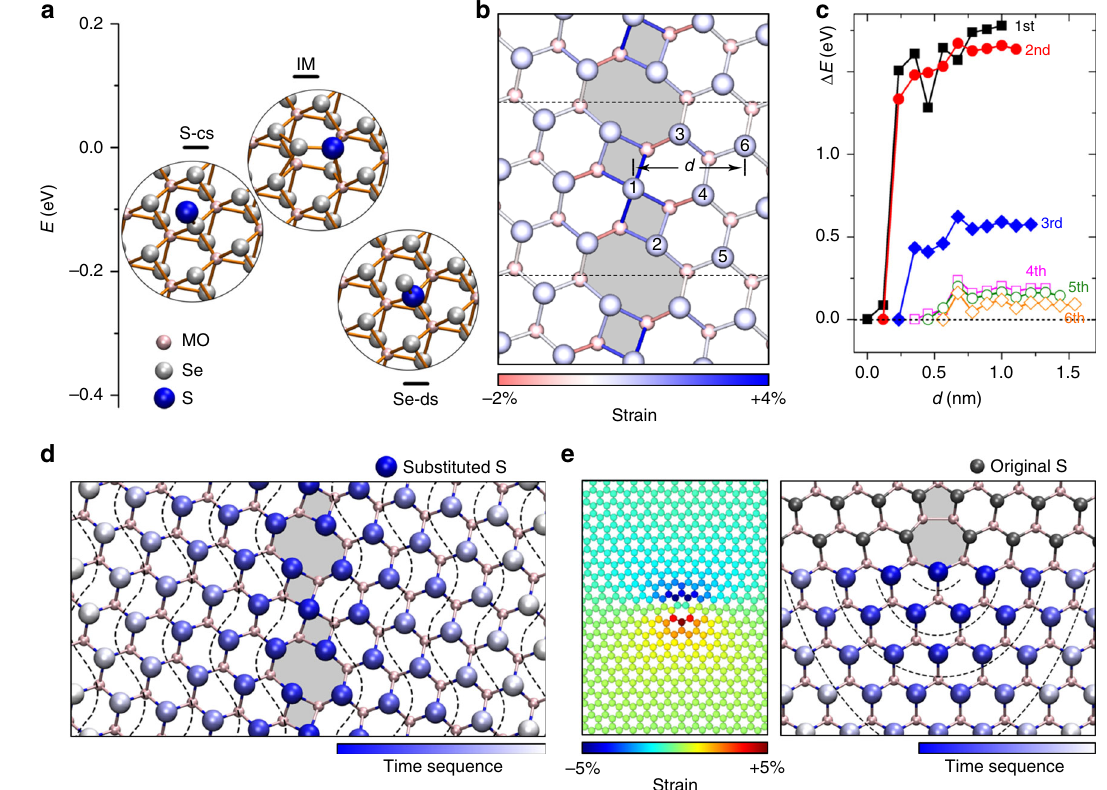
Fig. 5 Growth mechanism of the MoS 2 channels. a Reaction steps for the selenium substitution with sulfur and their relative energies. b Atomic structure of an 8|4|4|8 GB along with map of bond strain induced by the GB. The numbers 1 – 6 denote the sequence of sulfur substitution. d denotes the distance of reaction sites with respect to the GB line. c Calculated relative energies Δ E for the intermediate state in a as a function of d for the 1 – 6 sulfur atoms along the optimal substitution pathway. d Contour plot of substitution sequence (from blue to light gray) around the 8|4|4|8 GB. e In-plane strain distribution near a mis fi t Mo-rich 5|7 dislocation and the corresponding contour plot for the sequence of substitution